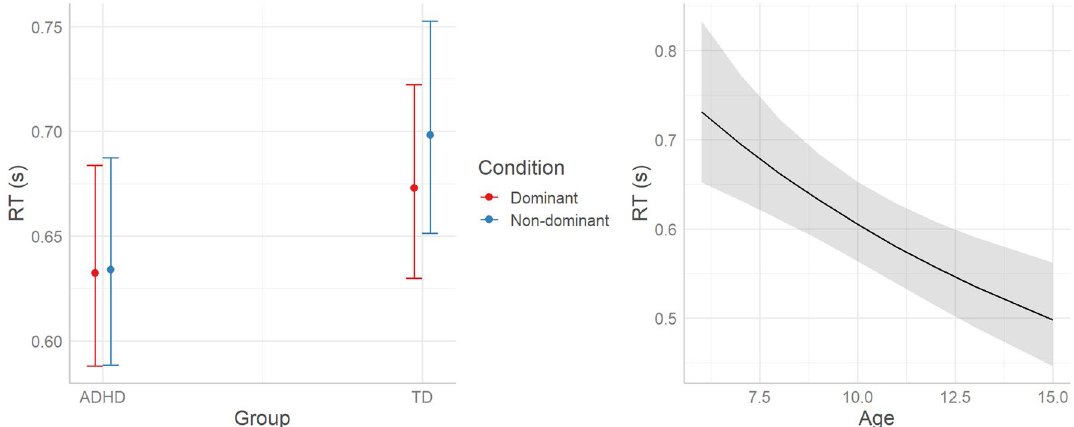
Figure 3. Predicted effects of Condition*Group and Age on RT (n trials = 6011, n ADHD = 17, n TD = 26, RT is expressed in seconds, estimated marginal means with whiskers representing 95% confidence interval; for the Age effect, shaded area represents the 95% confidence interval).